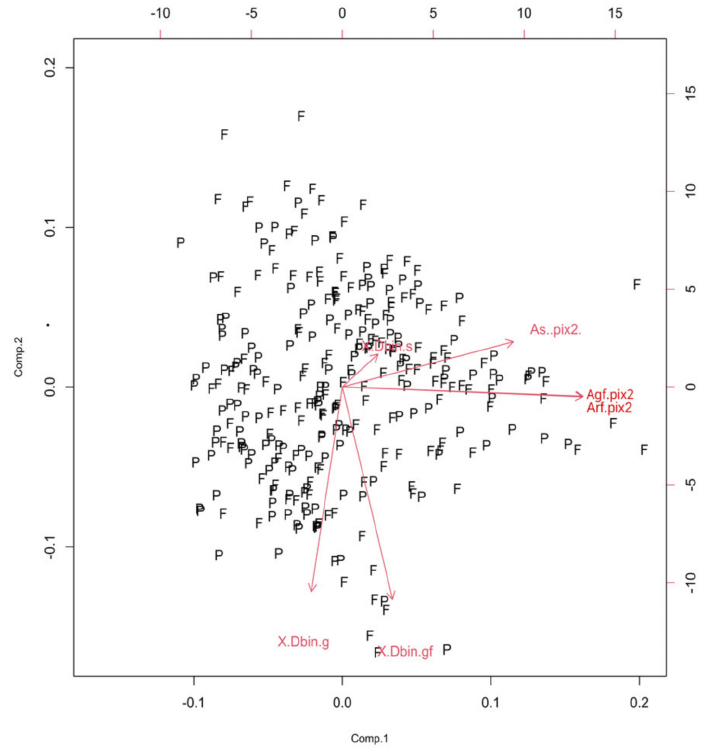
Figure 3. The PCA-based bi-plots of parameters characterizing morphological features in the given parameter space. Relationships between first two standardized principal components of the